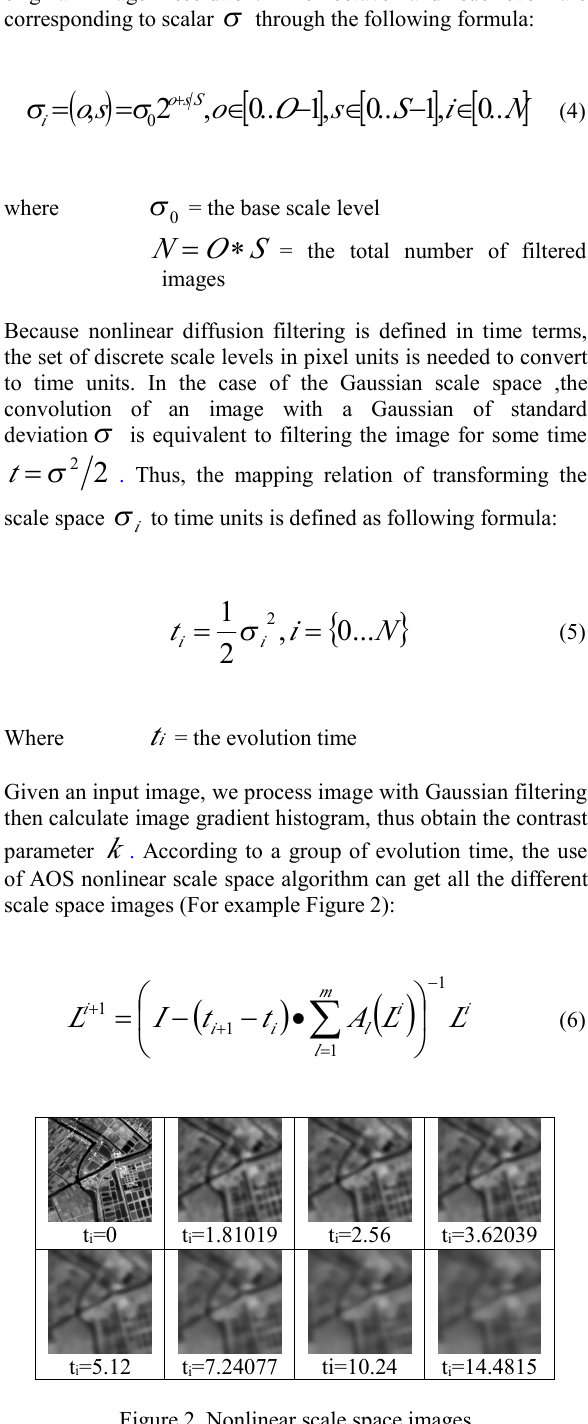
Figure 2. Nonlinear scale space images 2.22.22.22.2 FeatureFeatureFeatureFeature PPPPointointointointssss